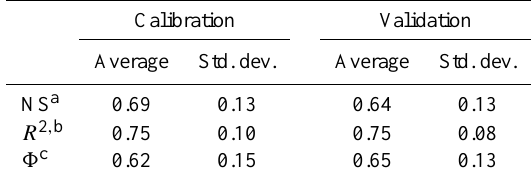
Table 1. Coupled Model Intercomparison Project – phase 5 general circulation models used in this study.